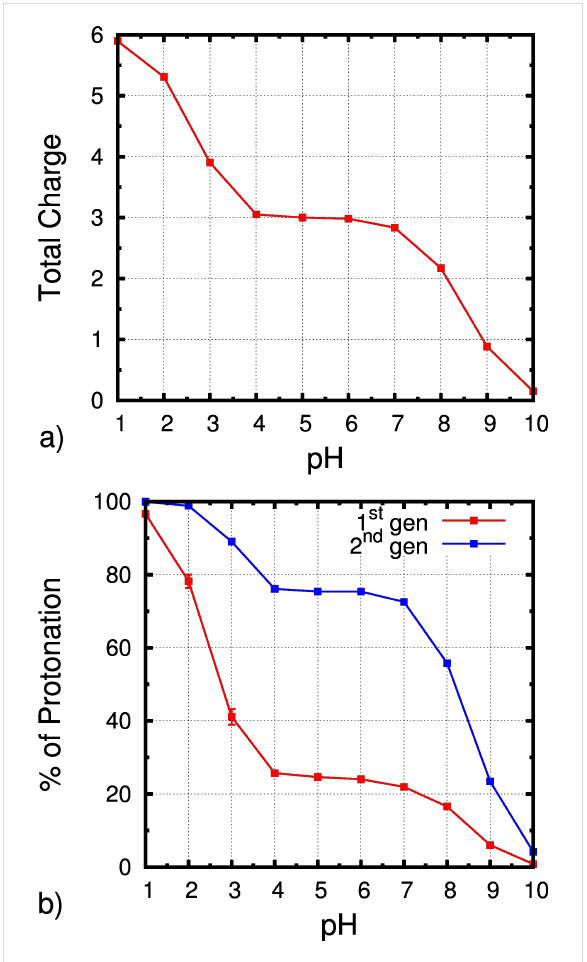
Figure 2: Full titration curve of the receptor (a) and the correspondent percentage of protonation in each generation